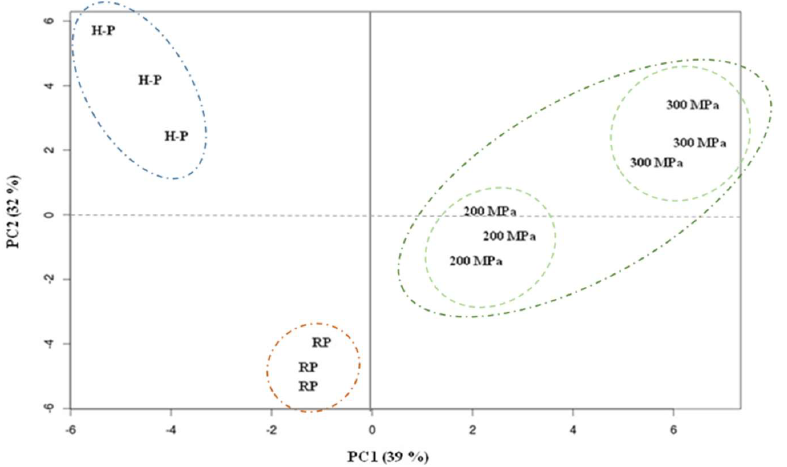
Figure 1. Loadings plot after principal component analysis of the individuals in the plane defined by the two first principal components (PC1 and PC2). PC1 (39%): First Principal Component, which explains 39% of total variability; PC2 (32%): Second Principal Component, which explains 32% of total variability; RP: raw product; H-P: homogenization-pasteurization at 18 + 4 MPa (pressure of first stage valve + second stage valve) and 65, and 80 ◦ C for 15 s; 200 MPa: ultra-high pressure homogenization at 200 MPa and Ti of 40 ◦ C; 300 MPa: ultra-high pressure homogenization at 300 MPa and Ti of 40 ◦ C.